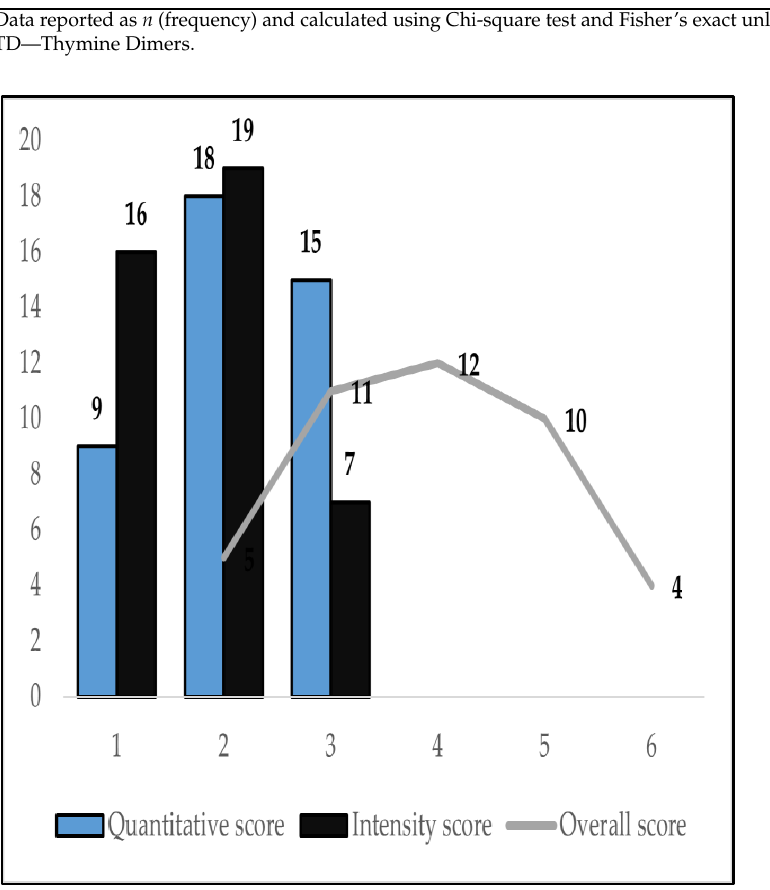
Figure 4. Distribution of TD-staining quantification score values, in tumor tissue TD-positive RCCs. Table 4. Correlation analysis of the studied variables.